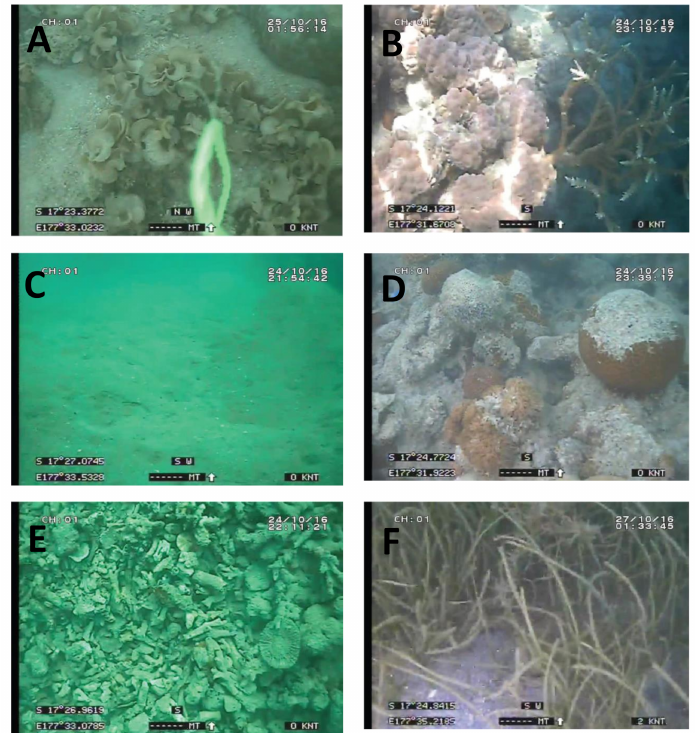
Figure 2. Six classes of benthic class types identified: ( A ) algae, ( B ) coral, ( C ) sand and gravel, ( D ) buried reef, ( E ) coral rubble and ( F )